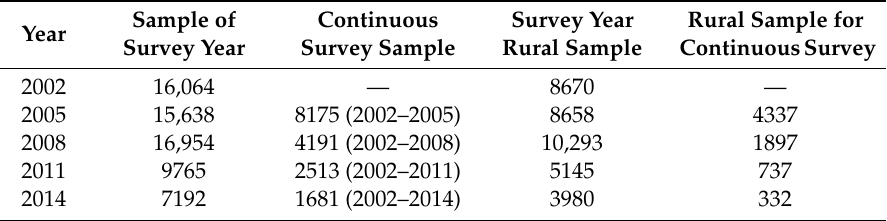
Table 1. Chinese Longitudinal Healthy Longevity Survey (CLHLS) data set sample content structure